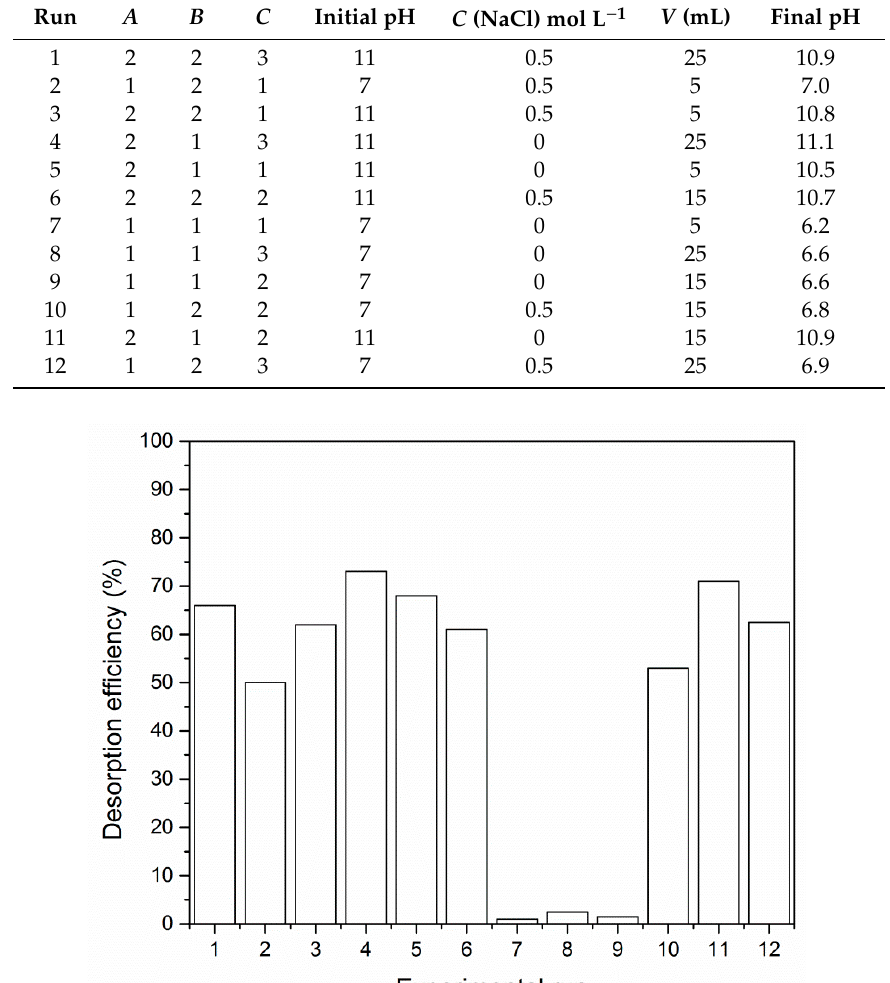
Table 2. Experimental design matrix.